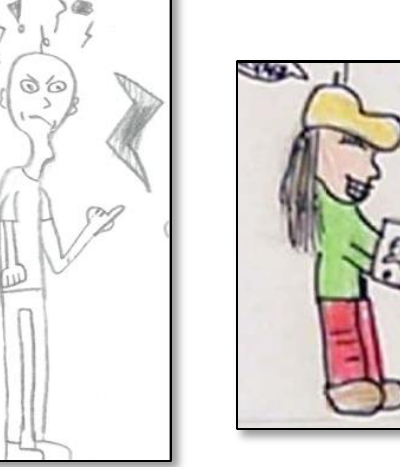
Figure 3. Examples of cyberbullies’ emotions. From left to right: Anger, Joy, Joy, Sadness. The phrase “Scusami Christian sono stato uno stupido” means “Sorry Christian, I was a stupid”.